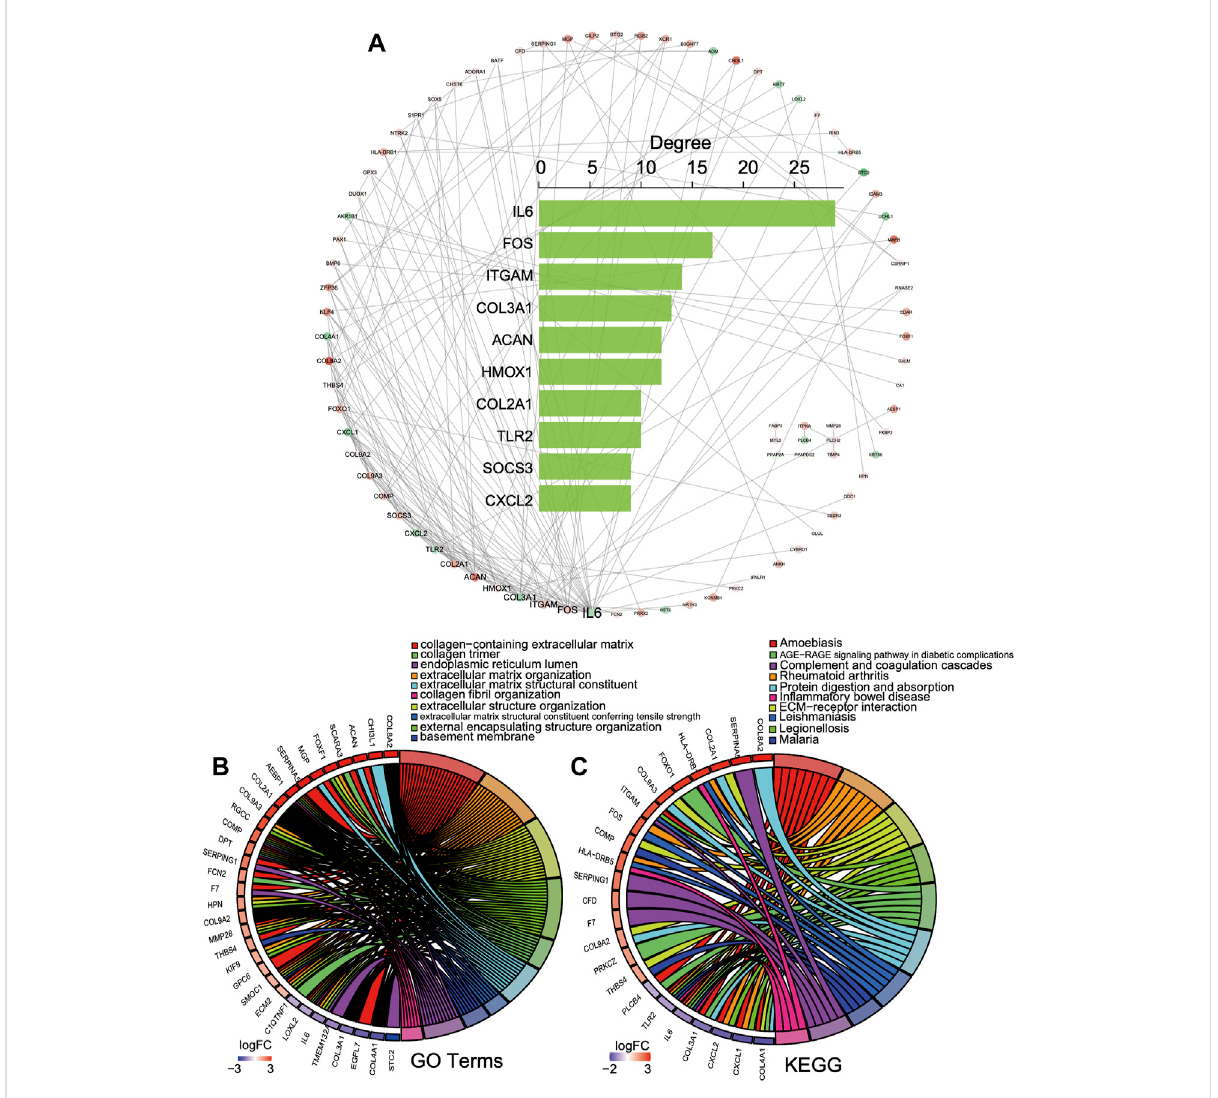
FIGURE 4 PPInetworkoftheDEGs. (A) PPInetworkandtop10genedegreedistribution:redrepresentsupregulated,andbluerepresentsdownregulated. (B, C) Hub gene relations in the top 10 GO terms and KEGG